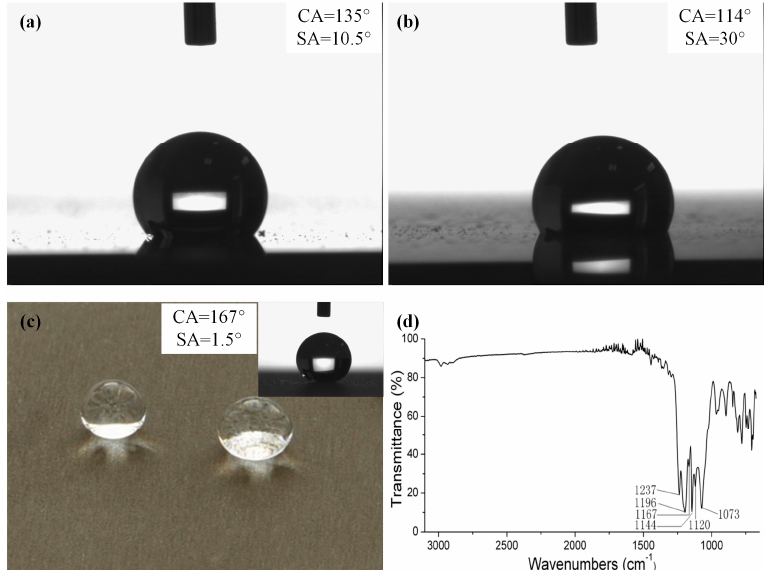
Figure 5. Images of contact angle (CA), sliding angle (SA) and Fourier transform infrared spectroscopy (FTIR) spectrum of the sample surface. ( a ) The treated surface after sandblasting and FAS modification; ( b ) the results after only electrochemical machining and FAS modification; ( c , d ) the results after sandblasting, electrochemical machining and FAS modification.